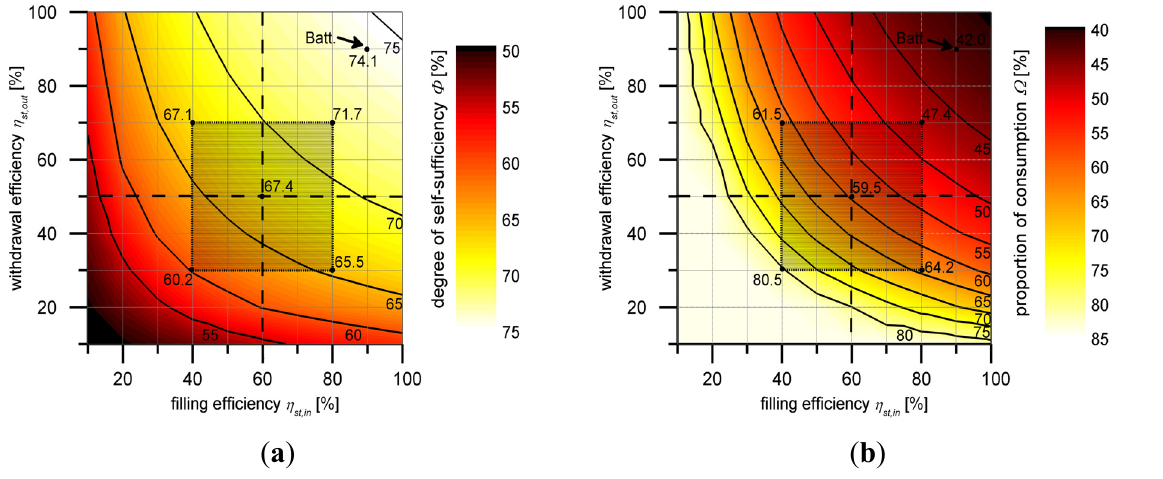
Figure 11. Evaluation dependent on storage efficiencies. ( a ) Degree of self-sufficiency; ( b ) Proportion of